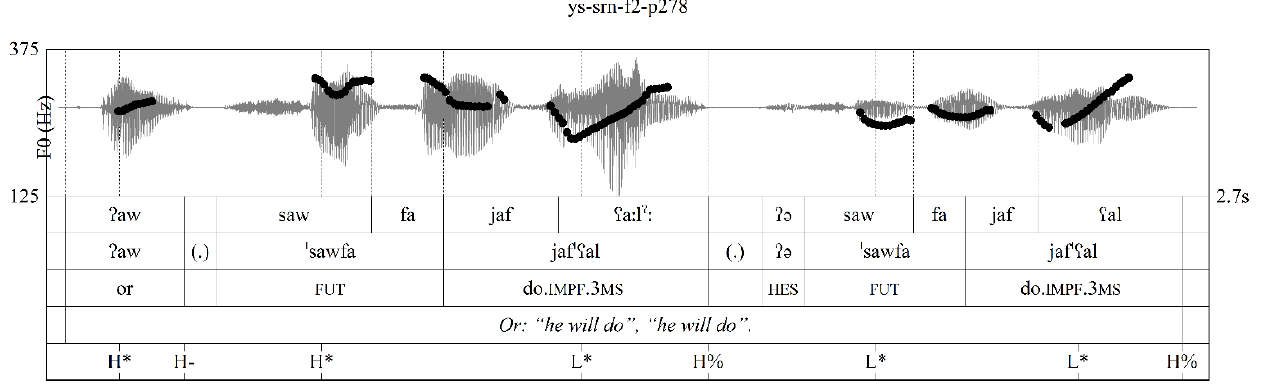
Figure 10. Sequence of F-coded turns produced with and without utterance-final laryngealization.